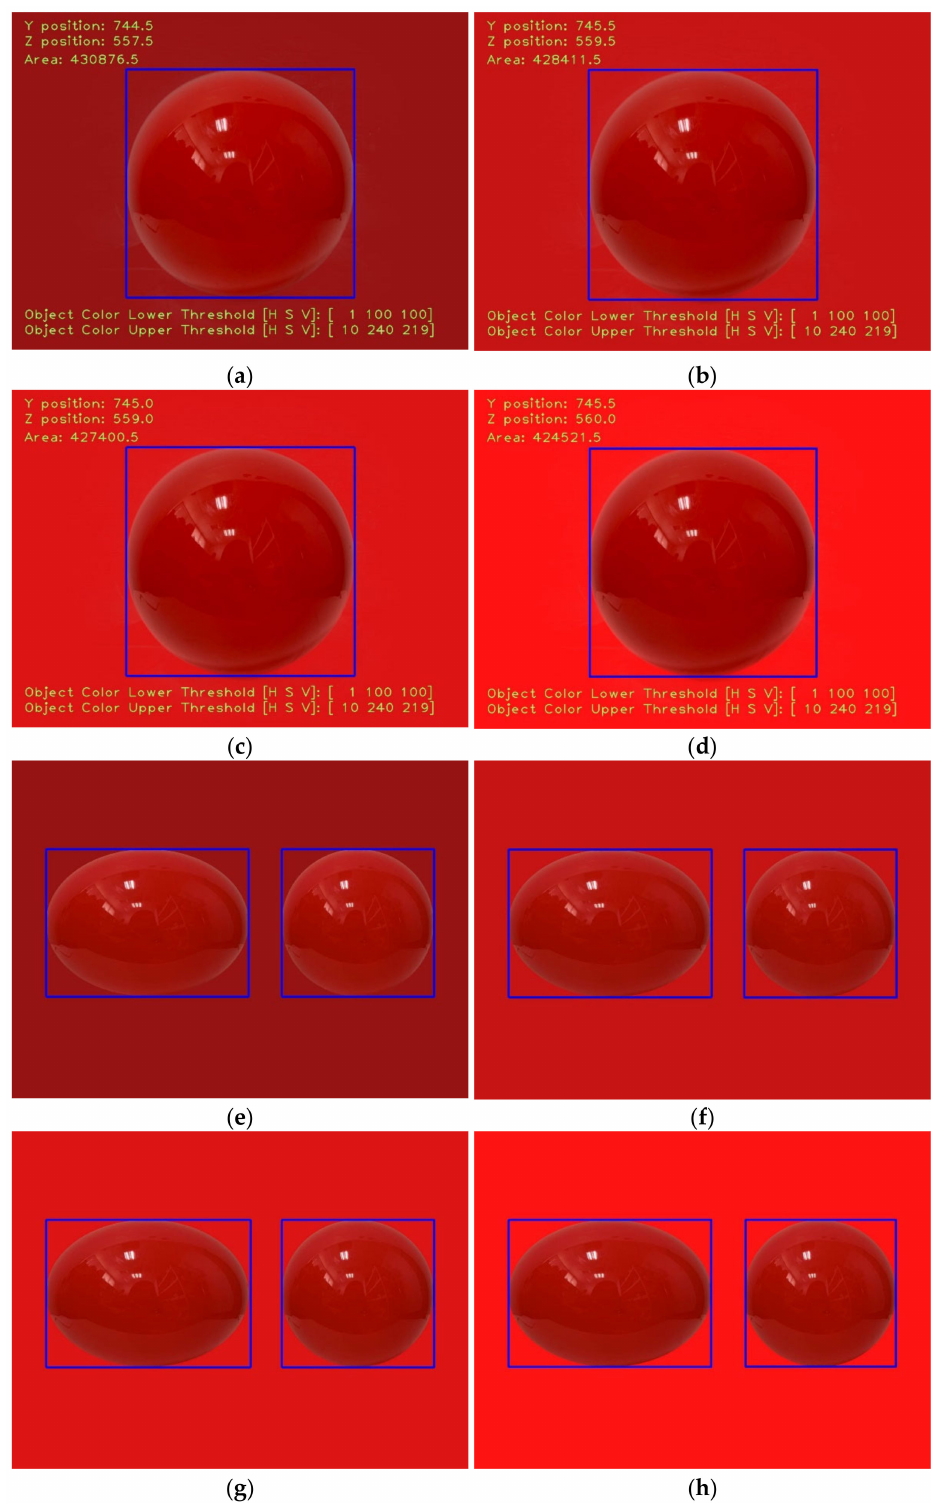
Figure 5. The ROI selections for ( a ) case A, ( b ) case B, ( c ) case C, ( d ) case D, ( e ) case E, ( f ) case F, ( g ) case G, and ( h ) case H,